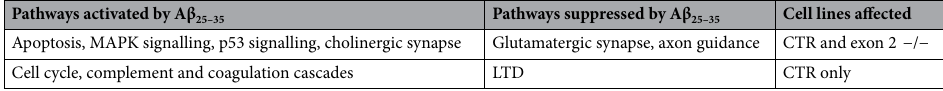
Table 2. A list of pathways altered by Aβ 25–35 in human neurons. Pathways significantly altered (activated/ suppressed) by Aβ 25–35 treatment in CTR and exon 2 −/− neurons, or CTR neurons